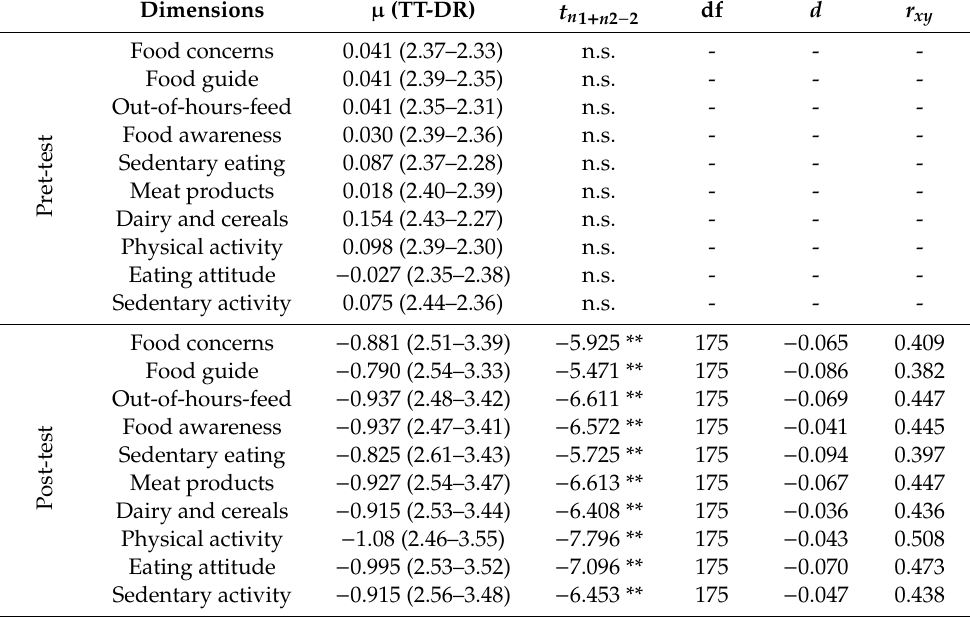
Table 2. Independent test for the two samples in the pre-test and post-test phase to highlight belonging to the same population determined by a common background.